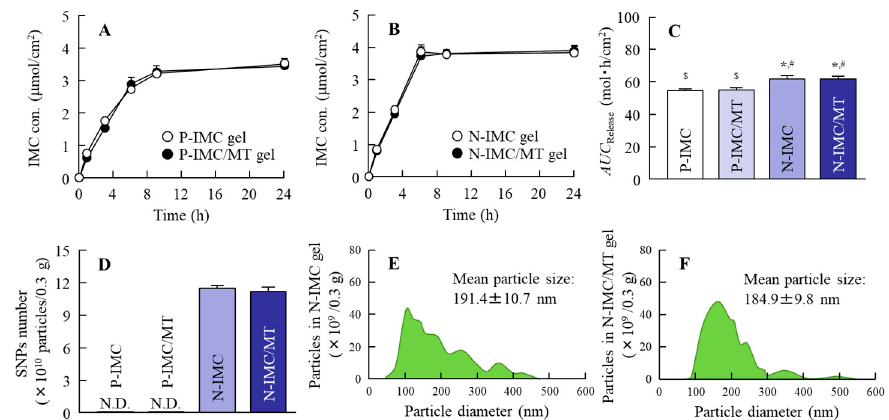
Figure 4. IMC release from the transdermal formulations through 20 µm pore membranes. ( A ); the drug release from the P-IMC and P-IMC/MT gels through the membranes. ( B ); the drug release from the N-IMC and N-IMC/MT gels through the membranes. ( C ); the area under the IMC concentration-time curve of drug release ( AUC Release ) for the IMC transdermal formulations. ( D ); the number of IMC SNPs released from the transdermal formulations 24 h after application. ( E ) and ( F ); the size